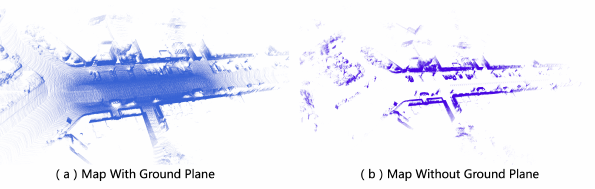
Figure 2. The impacts of ground plane. The left reconstruction result shows the messy ground plane points make it’s hard to split out the tree information, while the right is easy to split out the tree structure without the ground